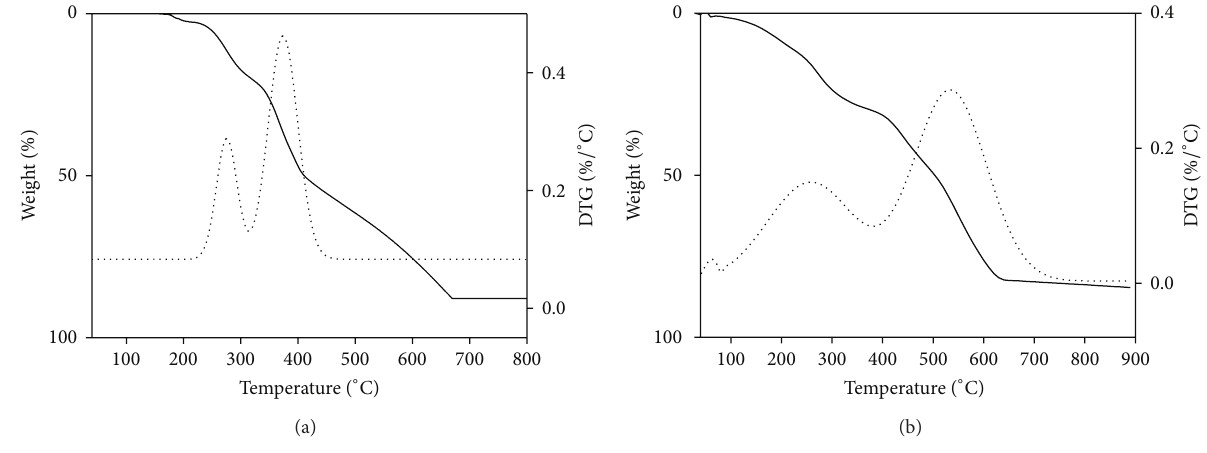
Figure 3: TG-DTG graph of (a) [Ni(L 4 ) 2 ] and (b) [Zn(L 4 ) 2 ] ⋅ H 2